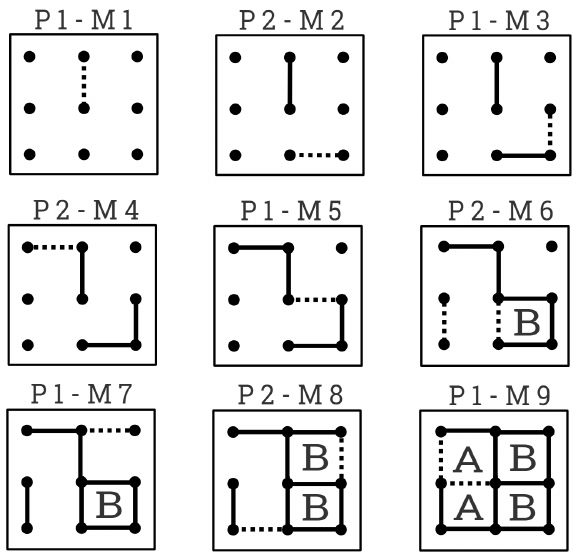
Figure 1. Dots and Boxes game between two